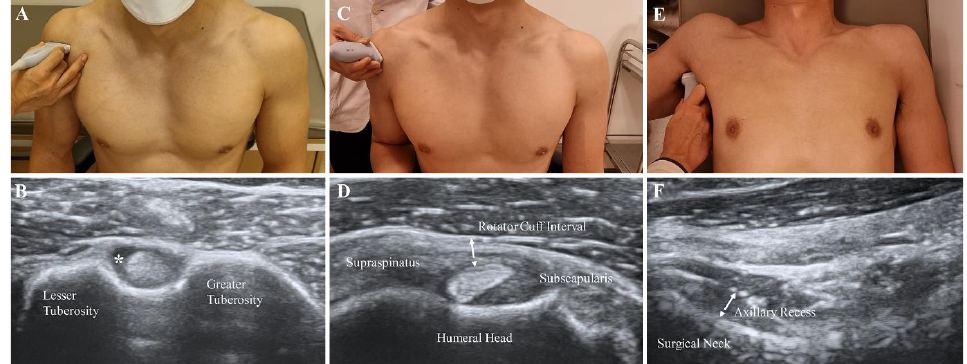
Figure 2. Measurement of features with B-mode ultrasound scan. ( A , B ) Effusion of the long head of the biceps tendon sheath (asterisk). ( C , D ) Oblique axial view of the soft tissue in the rotator cuff interval (dotted arrow). ( E , F ) Thickness of the axillary recess at the humeral surgical neck (dotted arrow).